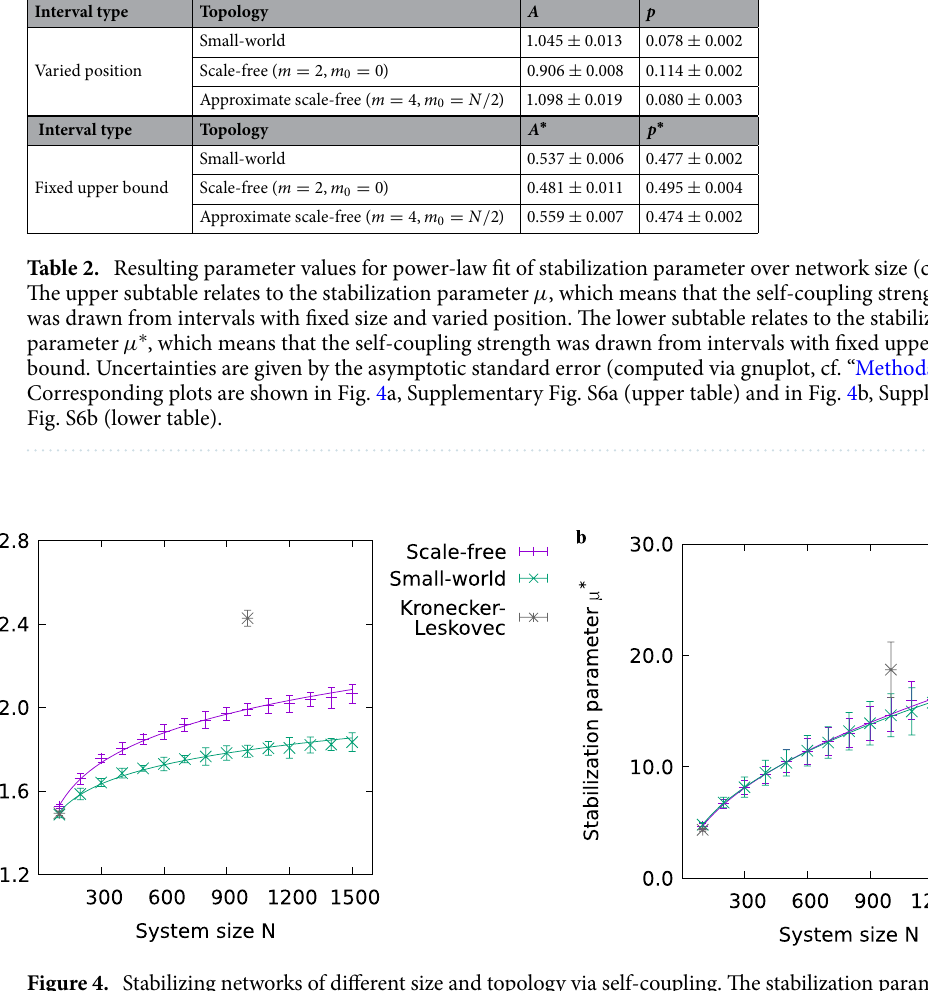
1 , stabilization ought to Table 2. At the same time, the function does account for the constraint that for N = happen at self-coupling strength 0. As indicated by the error values in Table 2, the fits that we obtained are very precise for both small-world networks and scale-free networks. Although some data points of the scale-free networks in Fig. 4a exhibit small visible deviations from the fit function, these remain well within the error range of the data points. Compared to our scale-free networks generated with the preferential attachment algorithm 0 (see Fig. 4), we obtained slightly different results for approximate scale-free 2 and m 0 with parameters m = = 4 and m 0 N / 2 . The corresponding plots are shown in networks generated with alternative parameters m = = Supplementary Fig. S6. From the results given in Fig. 4 and in Table 2, we can further evaluate the impact of the spread of the self- coupling strength values as defined by small intervals (varied upper bound/position) versus large intervals (fixed upper bound). For large intervals, we find that small-world and scale-free networks become stabilized